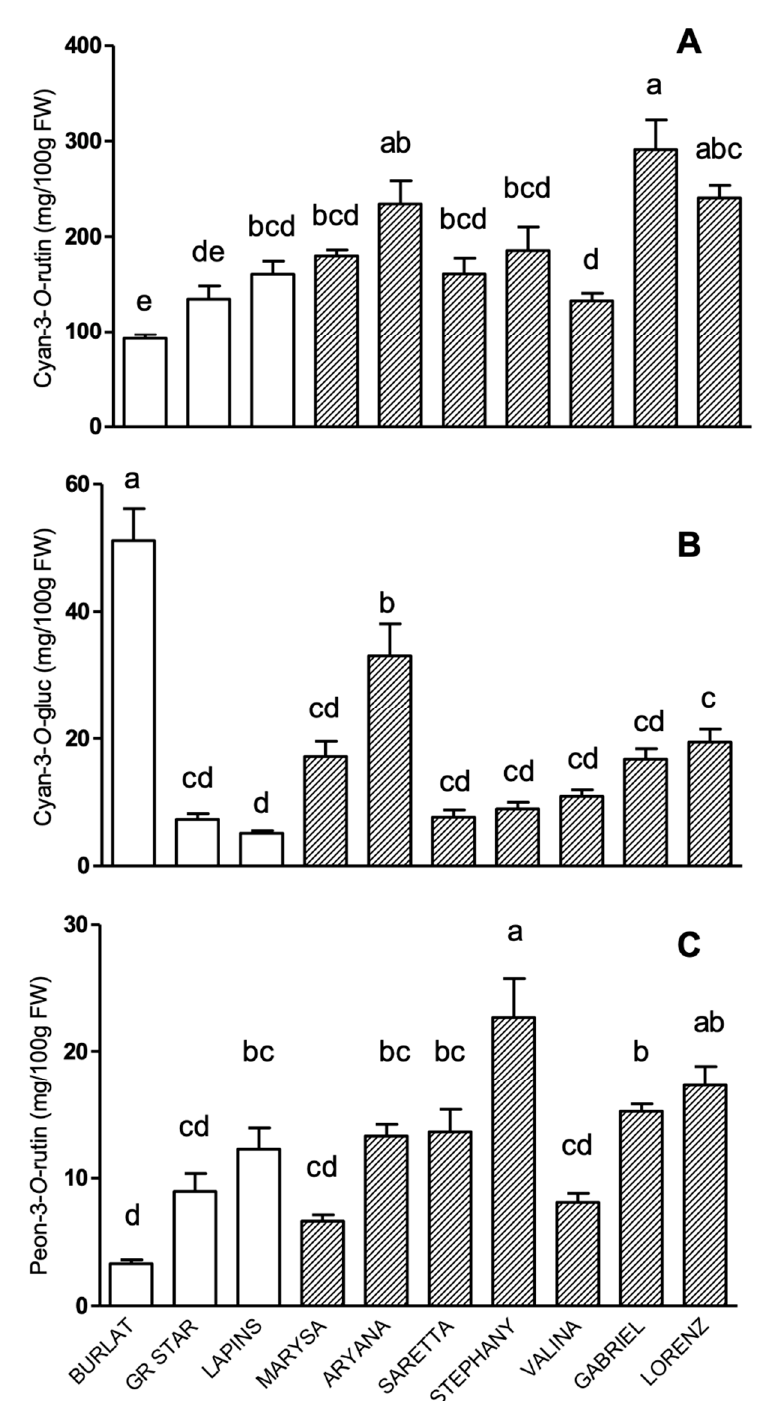
Figure 1. Anthocyanins levels (mg / 100 g FW) in sweet cherry cultivars: ( A ) cyanidin-3- O -rutinoside, ( B ) cyanidin-3- O -glucoside, and ( C ) peonidin-3- O -rutinoside. Data are the mean ± SEM of four biological replicates. Different letters indicate statistical significance ( p < 0.05).